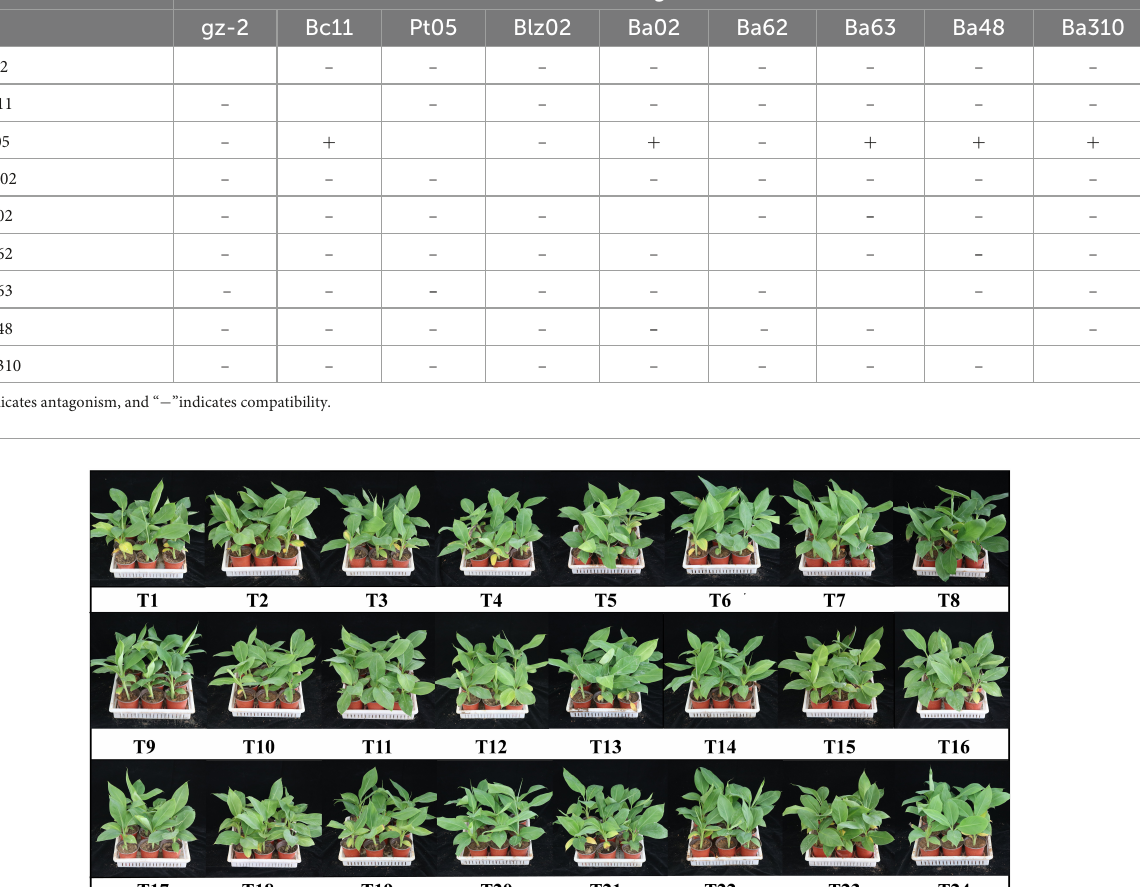
TABLE 3 Compatibility assay among Trichoderma and bacterial strains. Indicator strains